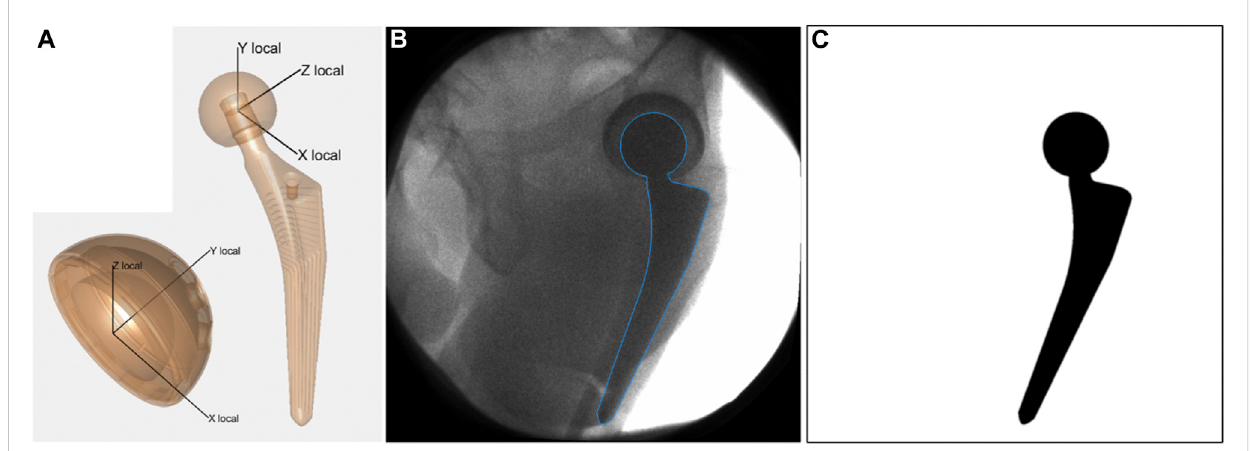
FIGURE 2 (A) Local coordinate systems de fi ned for acetabular cup and femoral stem. (B) Acquired fl uoroscopic image with overlay of registered femoral stem (blueline). (C) Simulatedimageofthefemoralstemattheregisteredpose.Itrepresentsthesimulated imagethatpresentedthehighestsimilaritywiththe acquired fl uoroscopic image, according to the gradient correlation similarity metric.